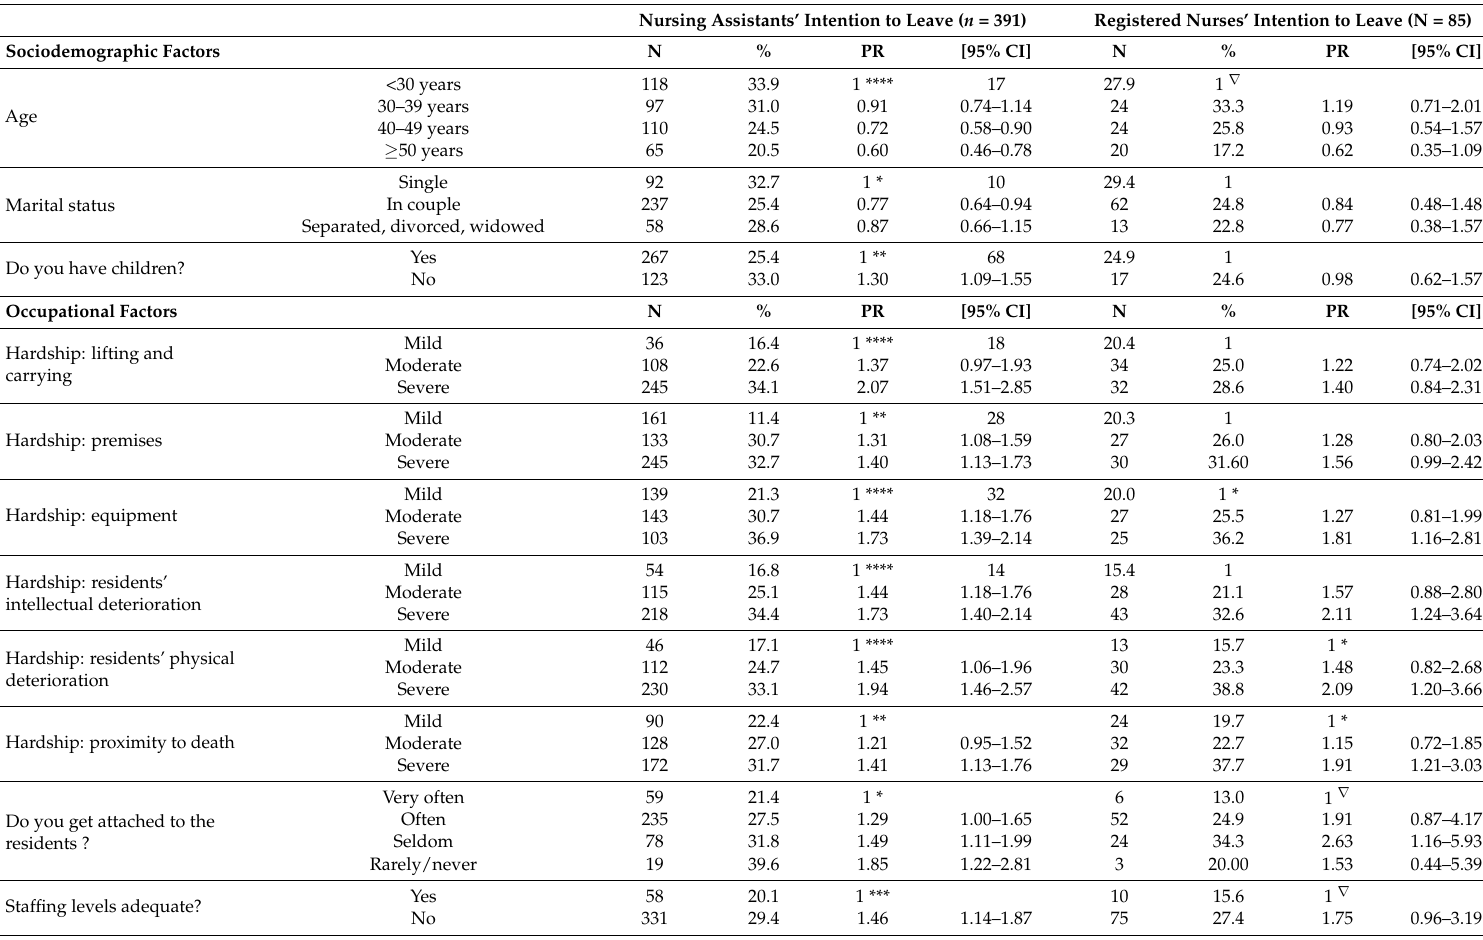
Table 1. Sociodemographic, occupational, psychosocial and medical factors associated with registered nurses’ and nursing assistants’ intention to leave work with the elderly, on univariate